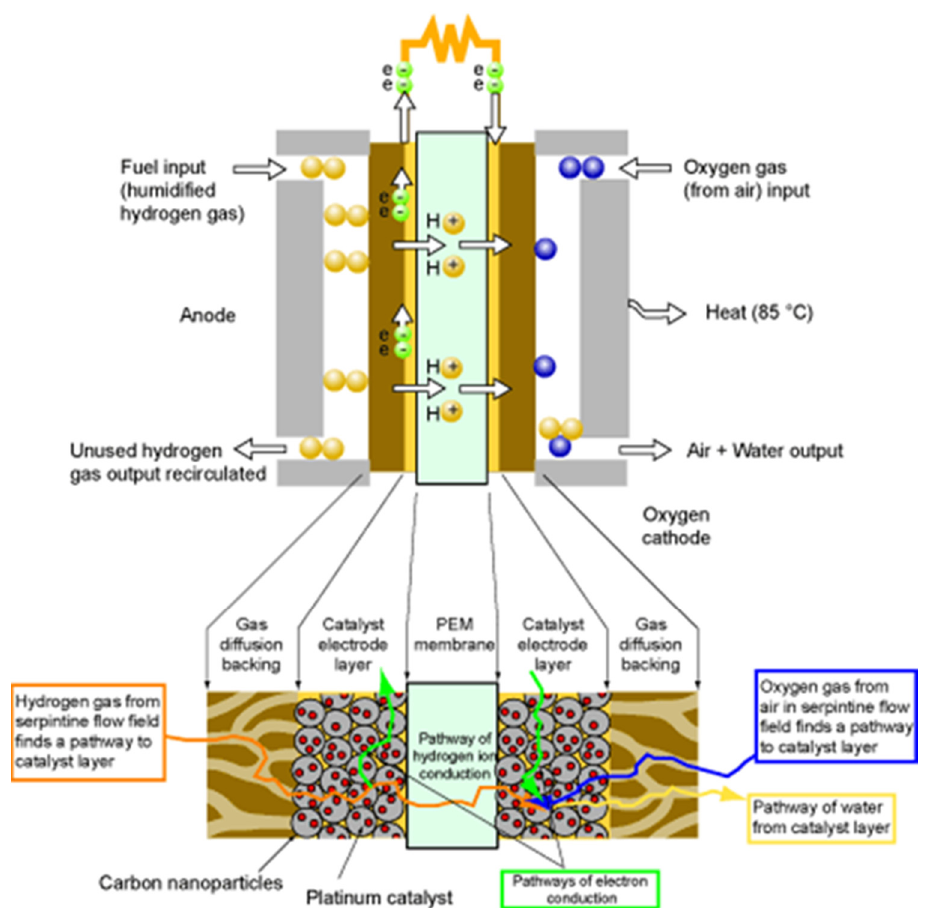
Figure 2. Working principle diagram of proton exchange membrane fuel cell (PEMFC).